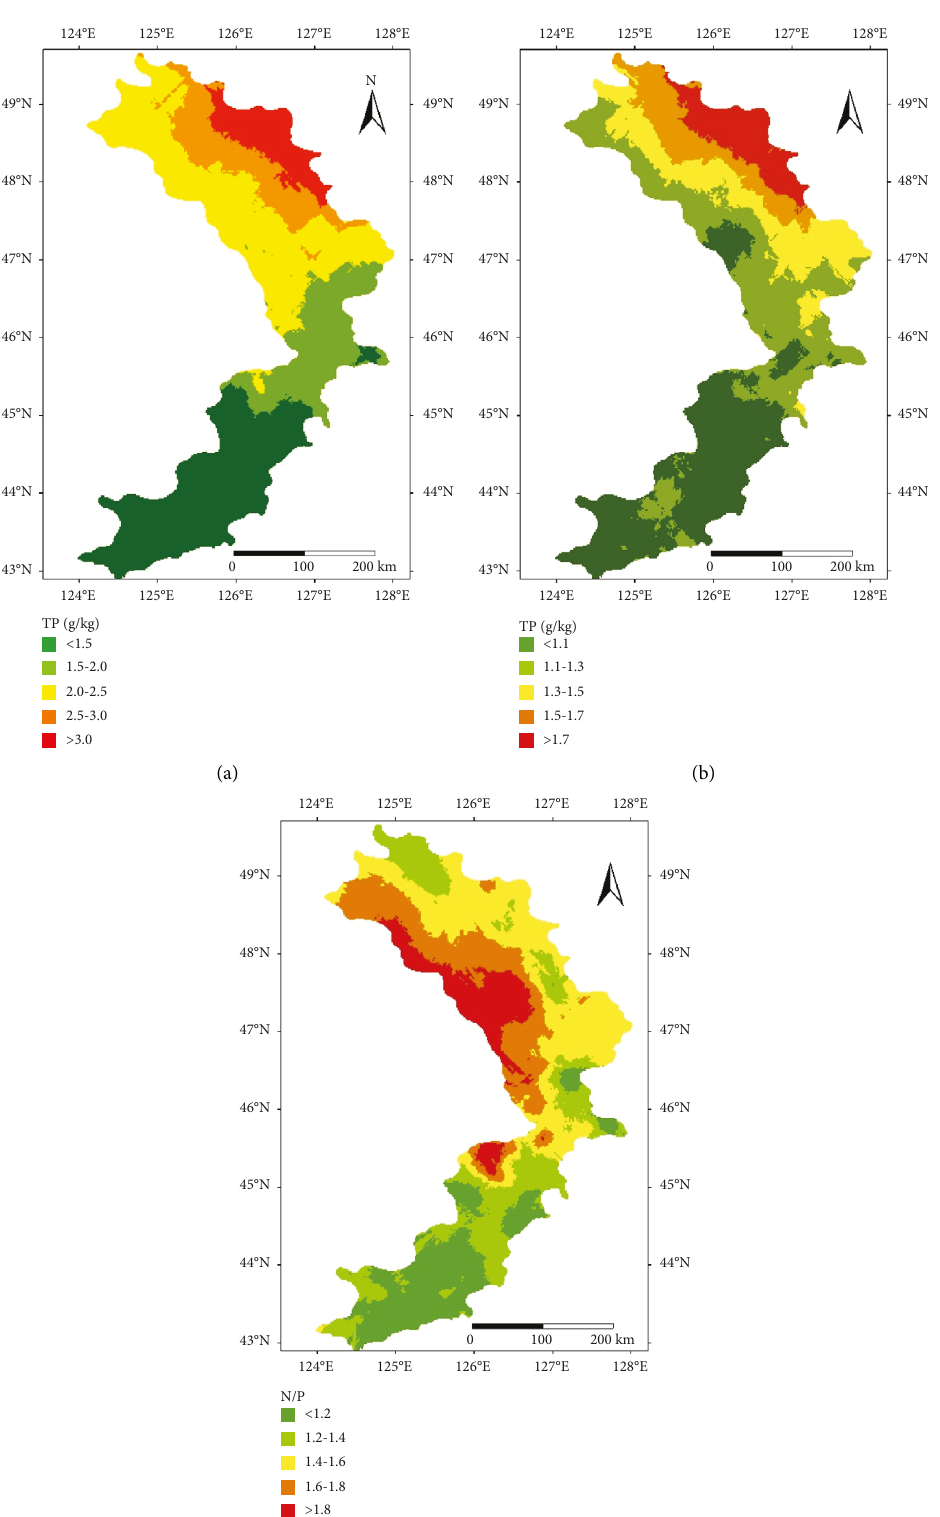
Figure 3: Soil TN, TP content, and spatial distribution of N/P (a). TN content; (b). TP content; and (c). N/P